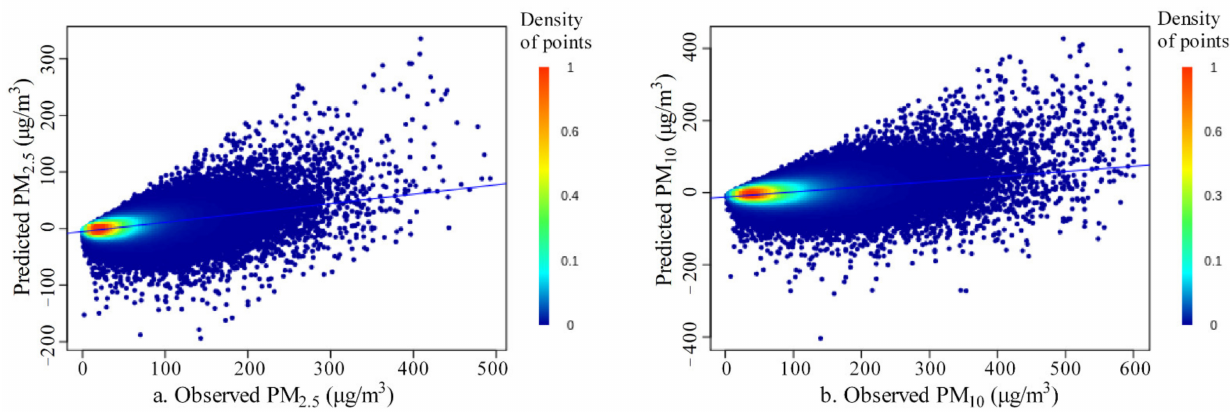
Figure 8. Scatter plots between observed values and residuals in the site-based independent testing (( a ) for PM 2.5 ; ( b ) for PM 10 ).